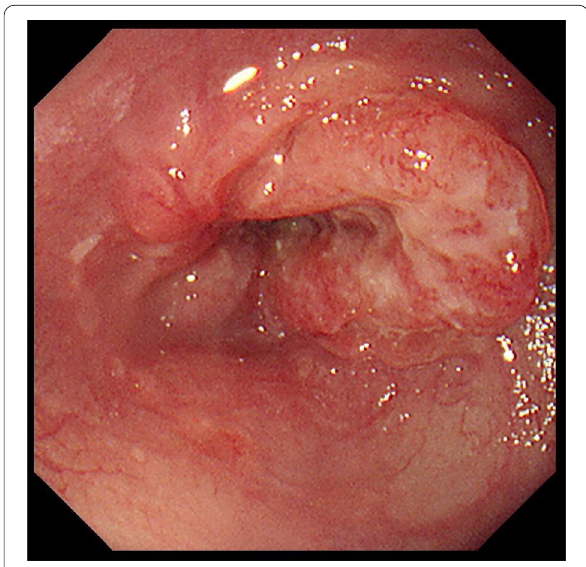
Fig. 5 Endoscopic findings in Case 3. A type 2 lesion was found in the middle thoracic